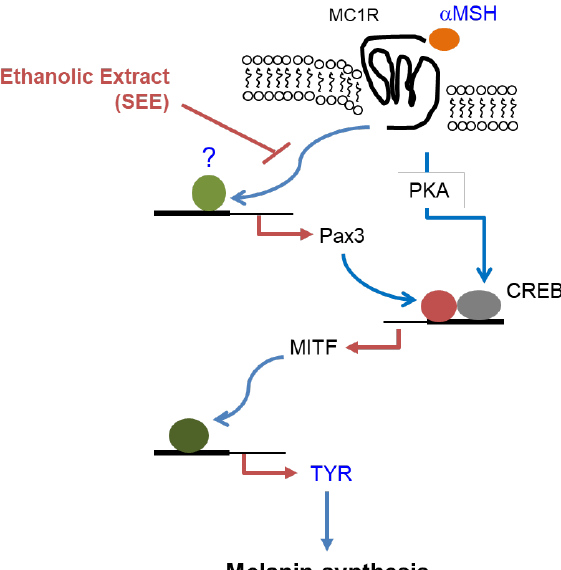
Figure 6. Hypothetical mode of action of SEE on the suppression of α -MSH-induced pigmentation in murine B16F10 melanoma cells. When α -MSH binds to MC1R on the surface of melanocytes, PKA is activated and induces MITF expression via CREB phosphorylation, leading to upregulation of melanogenic enzymes, including tyrosinase. In B16F10 melanoma cells, α -MSH can upregulate the Pax3 expression, which then stimulates MITF gene transcription. SEE inhibits α -MSH-induced Pax3 expression, resulting in the suppression of MITF-mediated TYR expression in B16F10 cells. α MSH, α -melanocyte-stimulating hormone; MC1R, melanocortin 1 receptor; PKA, protein kinase A; CREB, CRE-binding protein; MITF, microphthalmia-associated transcription factor; SEE, sorghum ethanolic extract.